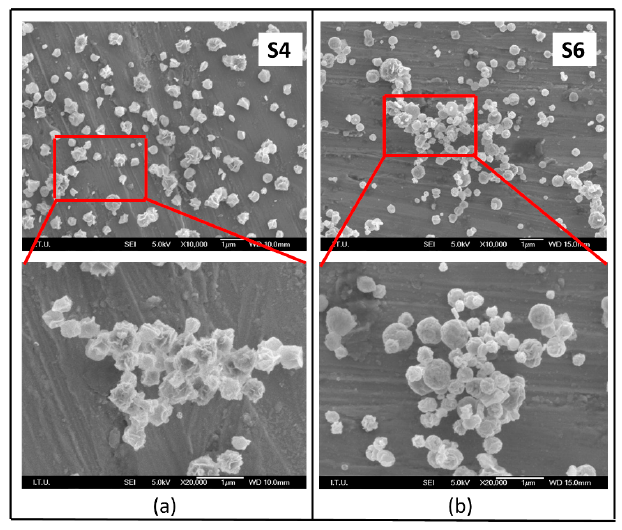
Figure 6. SEM micrographs of nanostructured ZnO particles synthesised from 0.02875 mol/L at 600 °C; ( a ) 0.75 L/min N 2 gas flow and ( b ) 0.5 L/min N 2 gas flow rate.